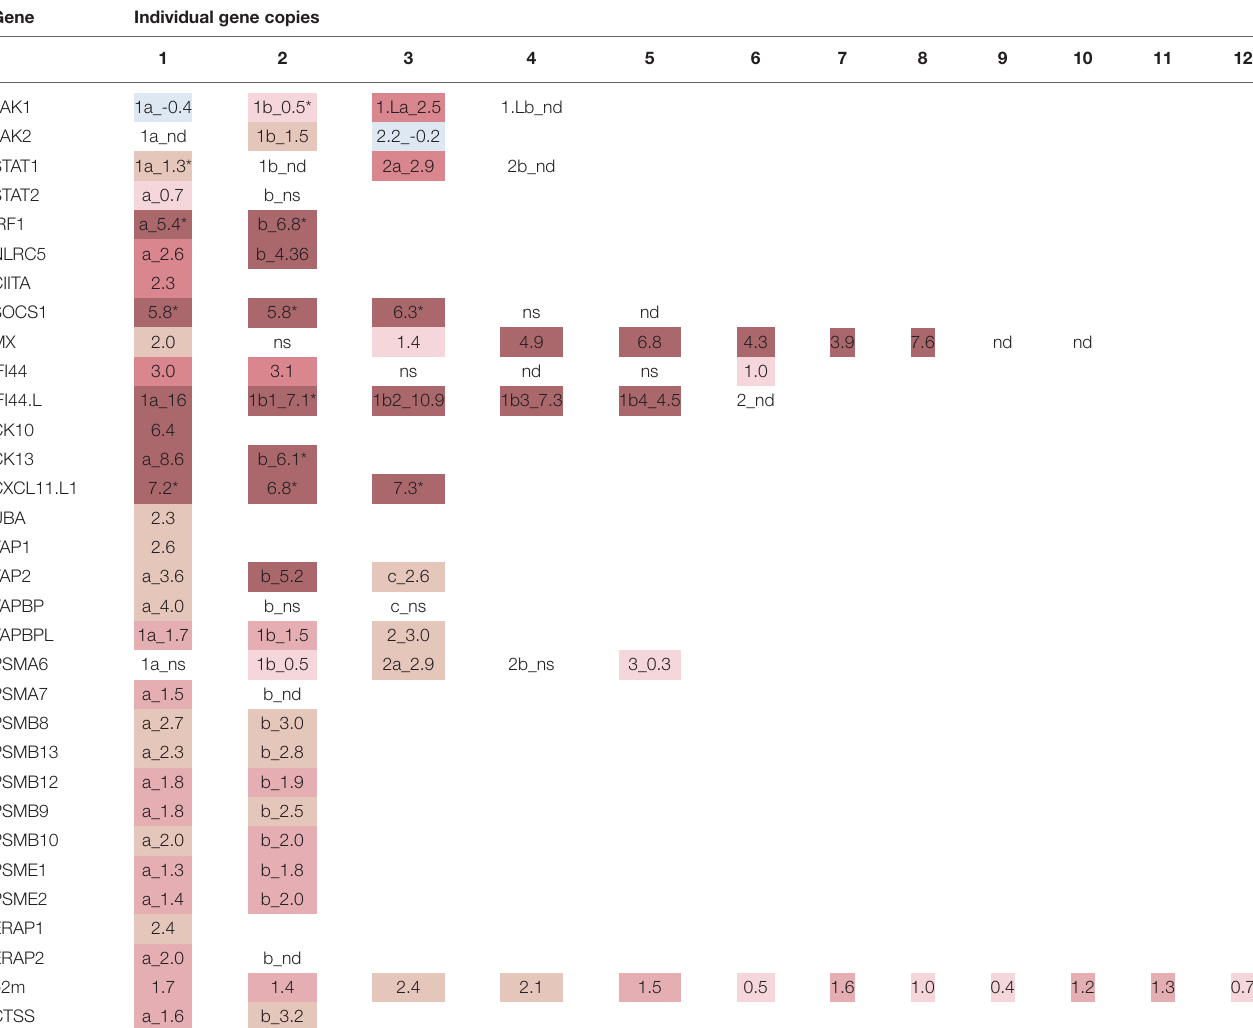
TABLE 5 | Log 2 -fold change for selected genes and their gene duplicates. Gene Individual gene